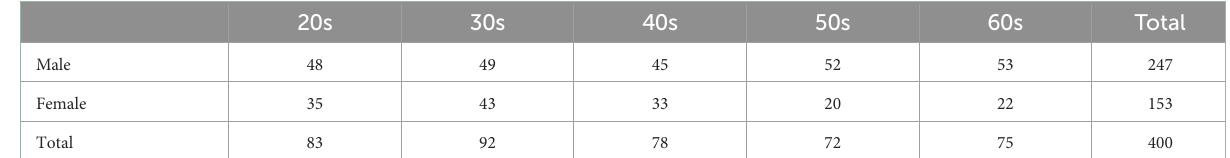
TABLE 1 Participants’ age groups and